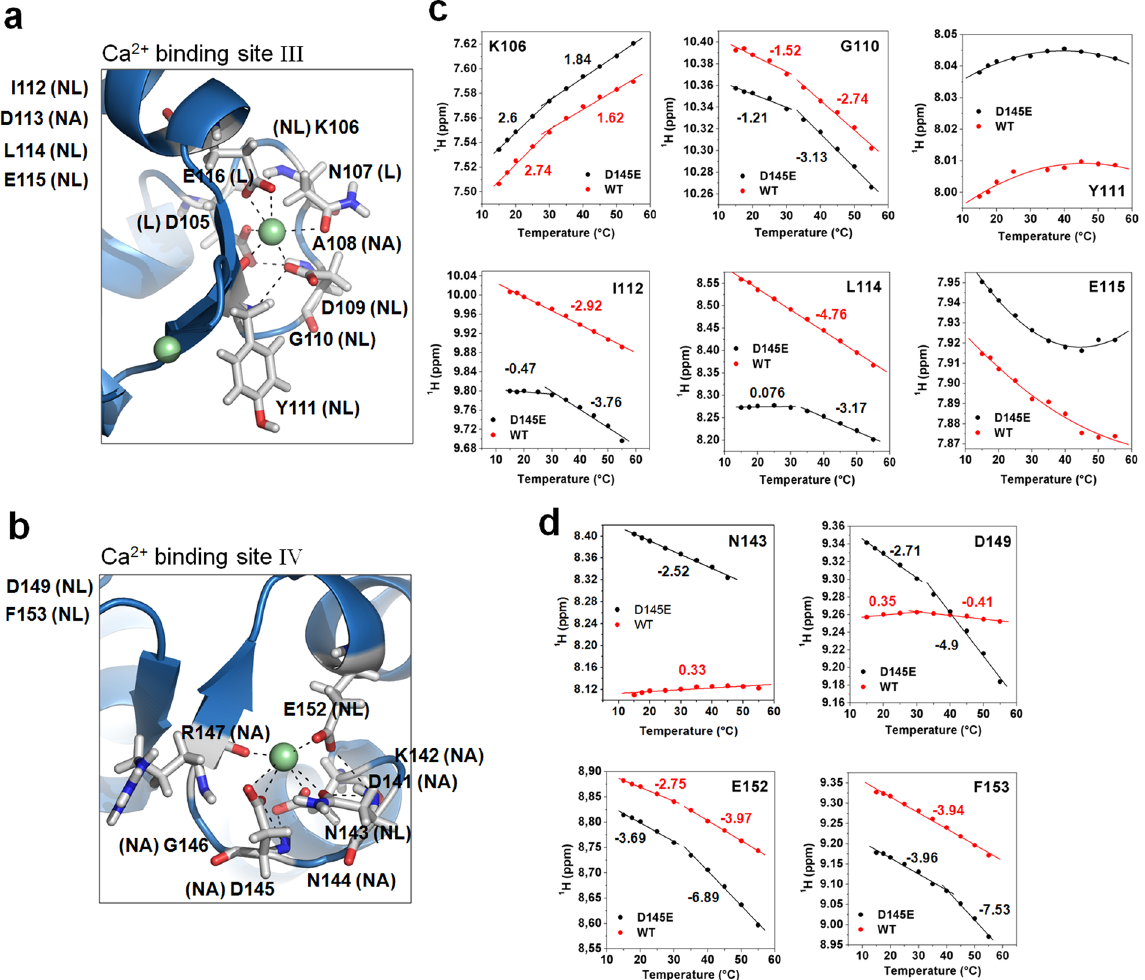
Figure 4. Residues with non-linear temperature coefficients for amide hydrogens are sampling a different chemical environment above the break. ( a , b ) Ca 2 + -binding sites III and IV reveal multiple residues with non- linear temperature dependence. Residues listed to the left of each panel are located before or after the cartoons in panels a and b (NL – nonlinear, L – linear and NA – not analysed). ( c , d ) Collection of 1 H chemical shifts with nonlinear behavior for residues located within sites III and IV, respectively. Numbers beside line segments in ( c–d ) represent temperature coefficients in ppb/°C. Calcium ions (green) are depicted in both sites but available evidence indicates they are bound only weakly (or not at all) in sites III and IV of